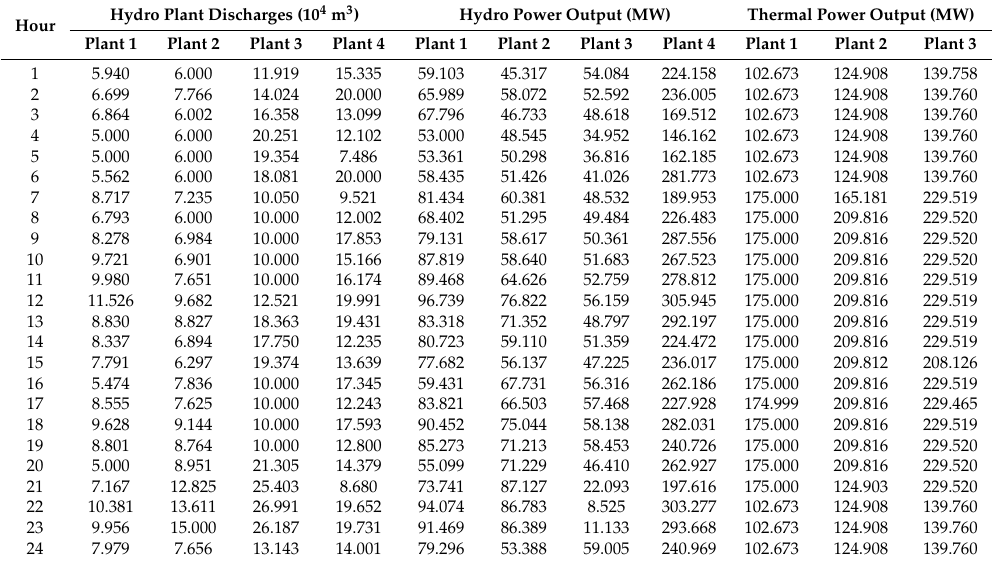
Table 5. Optimal discharges and power output for test system 2 case 1.